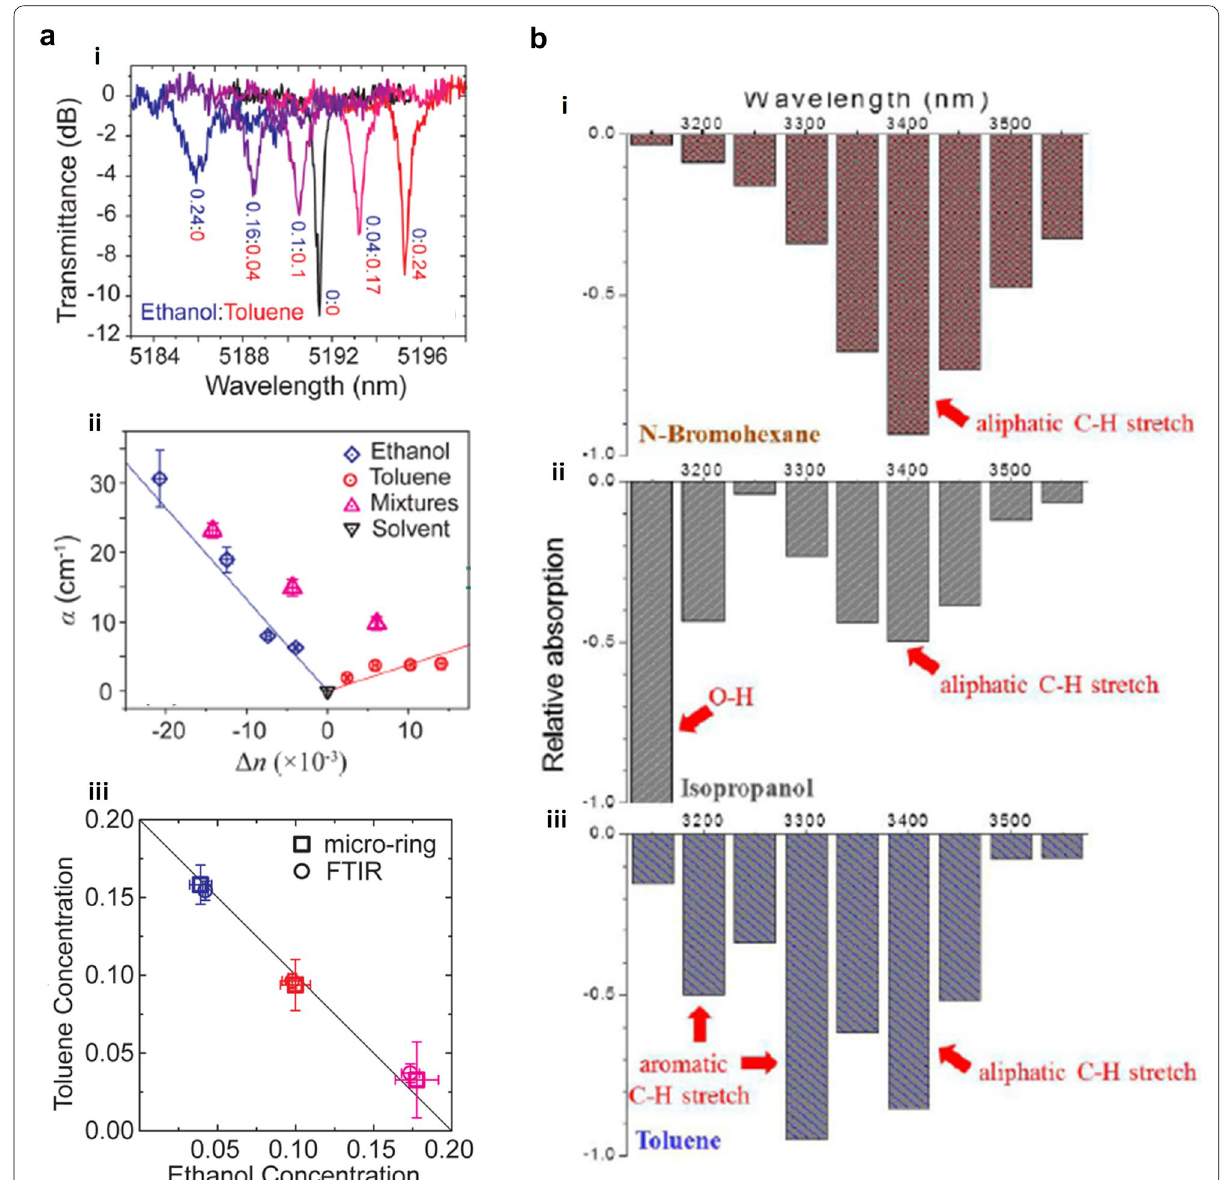
Fig. 8 MIR sensing analysis approaches. a Mixture sensing analysis using the resonance spectrum of an MRR (Reproduced with permission from [165]), (i) MRR resonance spectrum, (ii) Calculated absorption coefficient from extinction ratio change and refractive index change from resonant wavelength shift, (iii) Individual analyte concentration after linear transformation. b Relative absorption spectrum of three chemicals (Reproduced with permission from [156]), (i) N -Bromohexane, (ii) Isopropanol, (iii)